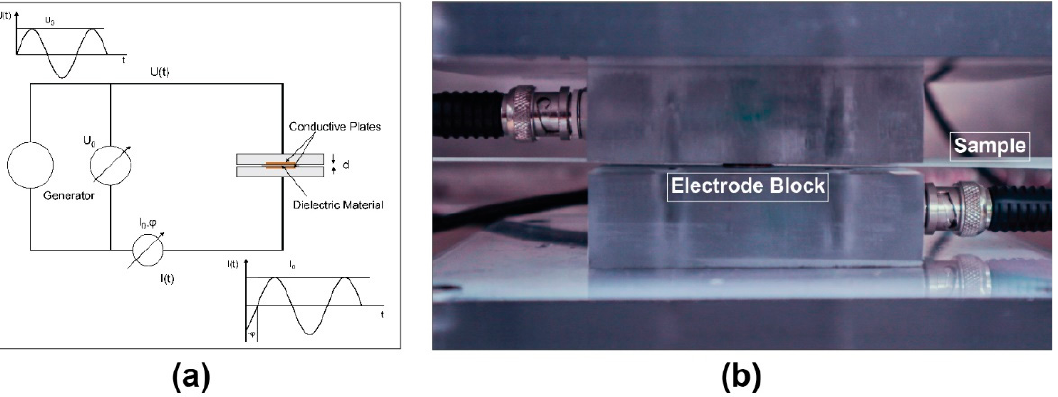
Figure 4. ( a ). Schematic of a sample placement between the electrodes in BbDS equipment [37]. ( b ). Experimental setup for BbDS.